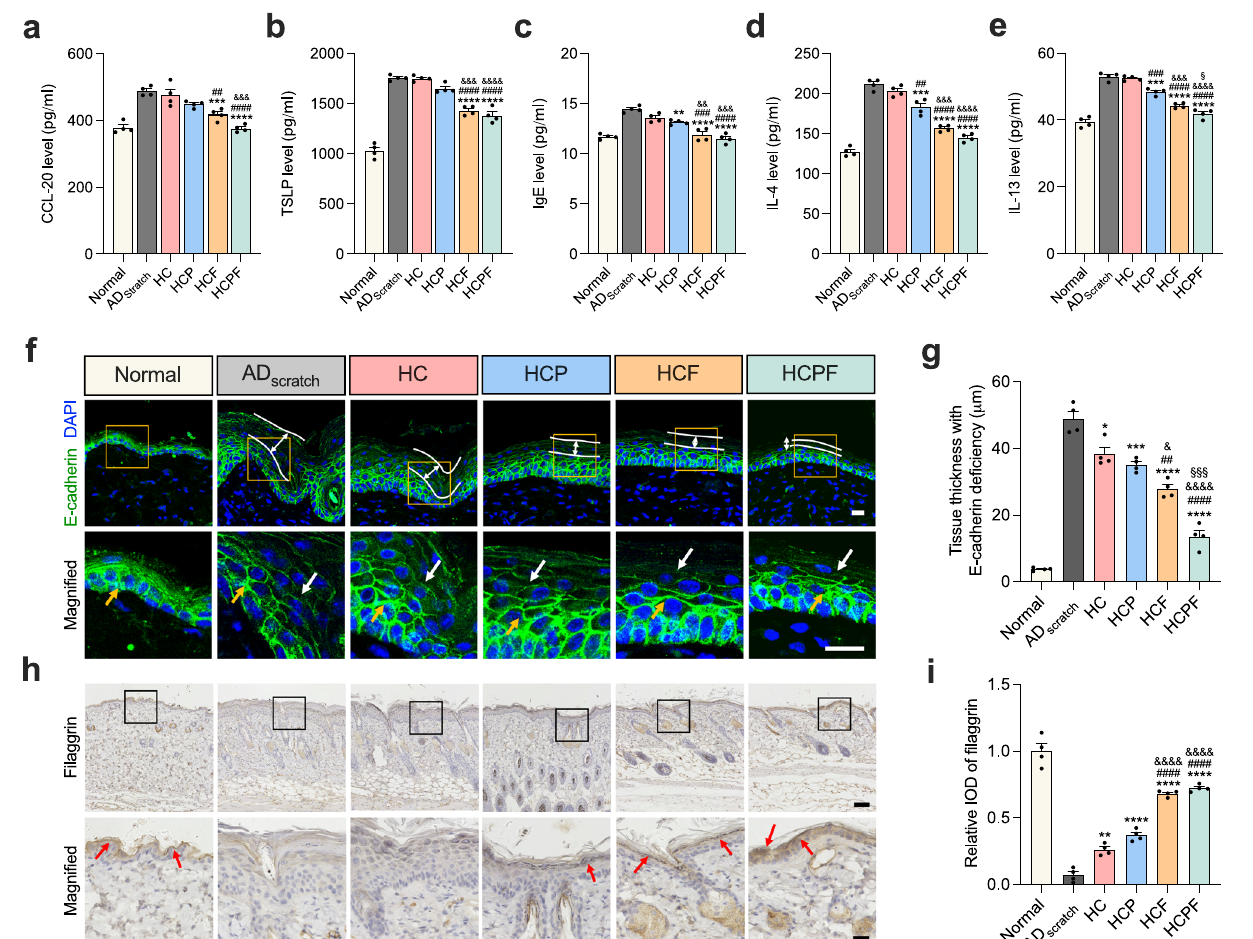
Fig. 7 | HCPFhydrogels reduce in fl ammation and epidermal barrier damage in ADmice.a – e CCL-20,TSLP,IgE,IL-4,andIL-13levelsintissuesofeachgroup, n =5 mice. f Fluorescent staining of E-cadherin (green) and DAPI (blue) in each group. Scale bar, 20 µ m. The white lines denote the de fi cient area of E-cadherin in the epidermis. In the magni fi ed images, the yellow arrows denote intact intercellular junctions represented by intact E-cadherin, while the white arrows indicate de fi - cient E-cadherin. g Quanti fi cation of tissue thickness with E-cadherin de fi ciency fromimagesin( f ), n =4mice. h Immunohistochemistrystainingof fi laggrinineach